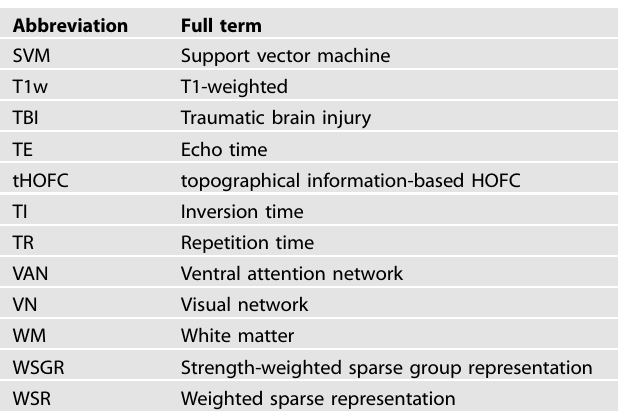
Table 1. Abbreviations used in the